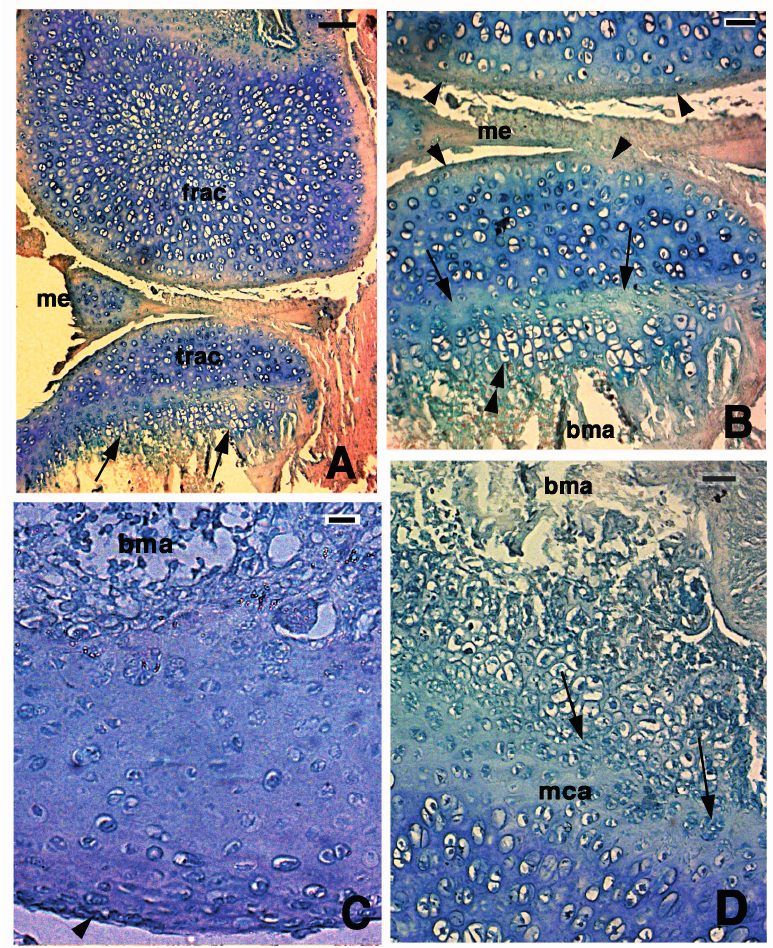
Figure 4. Histological aspects of the knee 14 days after the lesion. ( A ) In this case, the two apposed articular surfaces, femur at the top and tibia at the bottom, appear made of a highly cellular cartilaginous tissue. In the tibia, the beginning of a serial cartilage is present (arrows). Bar, 50 µm; ( B ) Close-up of the apposed articular cartilaginous surfaces where flat sinovial layers are present (arrowheads). The arrows indicate the presence of a likely resting and proliferating cartilaginous region where chondroblasts start to pile and form the hypertophic chondrocytes (double arrowheads). Bar, 20 µm; ( C ) Detail on the regenerated articular cartilage of the femur featuring flat superficial chondrocytes (arrowhead) and absence of piled condrocytes in contact with the bone marrow where the metaphyseal plate will reform later. Bar, 10 µm; ( D ) Detail of the more basophilic regenerated femur cartilage that confines with the proliferating region of a forming metaphyseal plate (arrows on some piled chondroblasts). Bar, 20 µm. Legends : bma, bone marrow; frac, femur regenerated articular cartilage; mca, metaphyseal plate; me, meniscus; trac, tibia regenerated articular